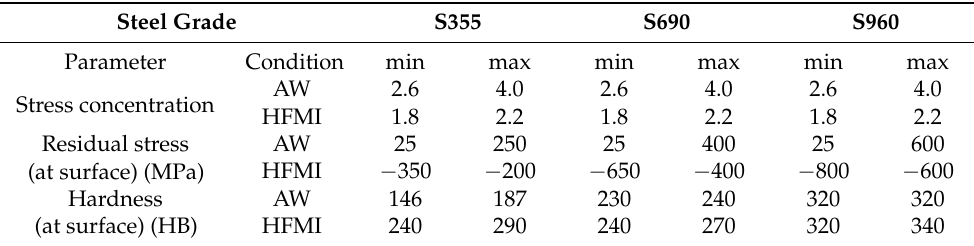
Table 2. Cyclic material parameters for strain – life curve. Table 2. Adopted parameters for parametric analysis of TSM model.